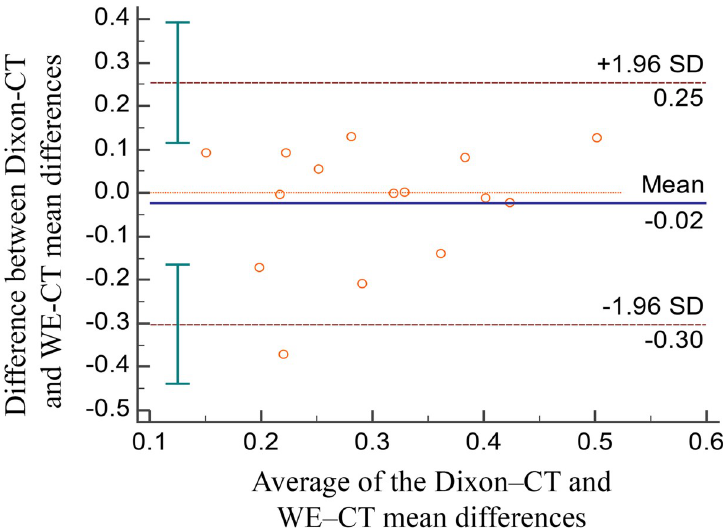
Fig 4. Bland–Altman plots. Bland–Altman plots comparing the mean difference of WE-VIBE 3D-MRI vs. CT with the mean difference of Dixon-VIBE 3D-MRI vs.